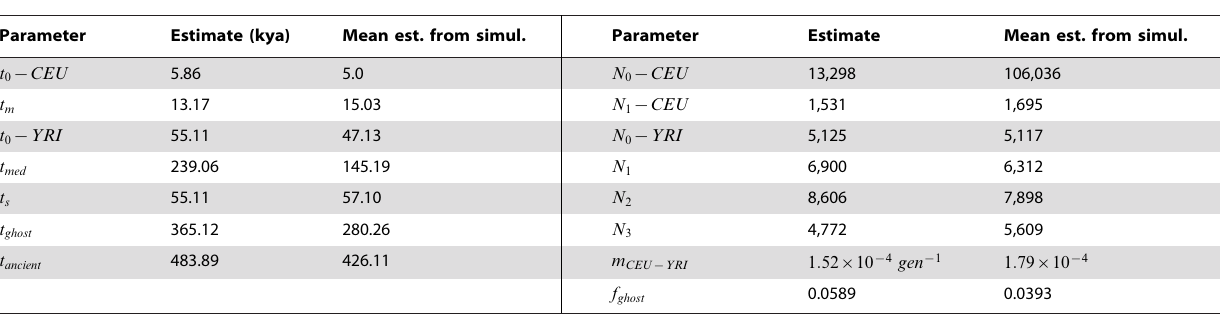
Table 2. Demographic parameters estimated from trio data.